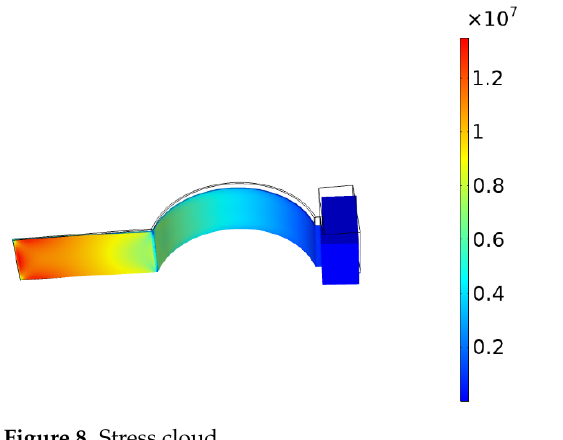
Figure 8. Stress cloud.